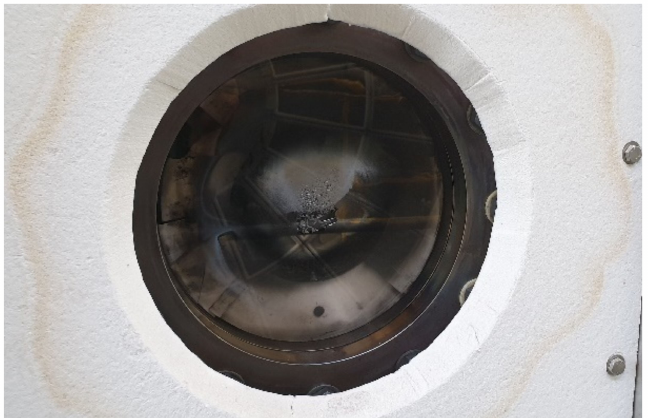
Figure 7. Quartz window of reactor (after